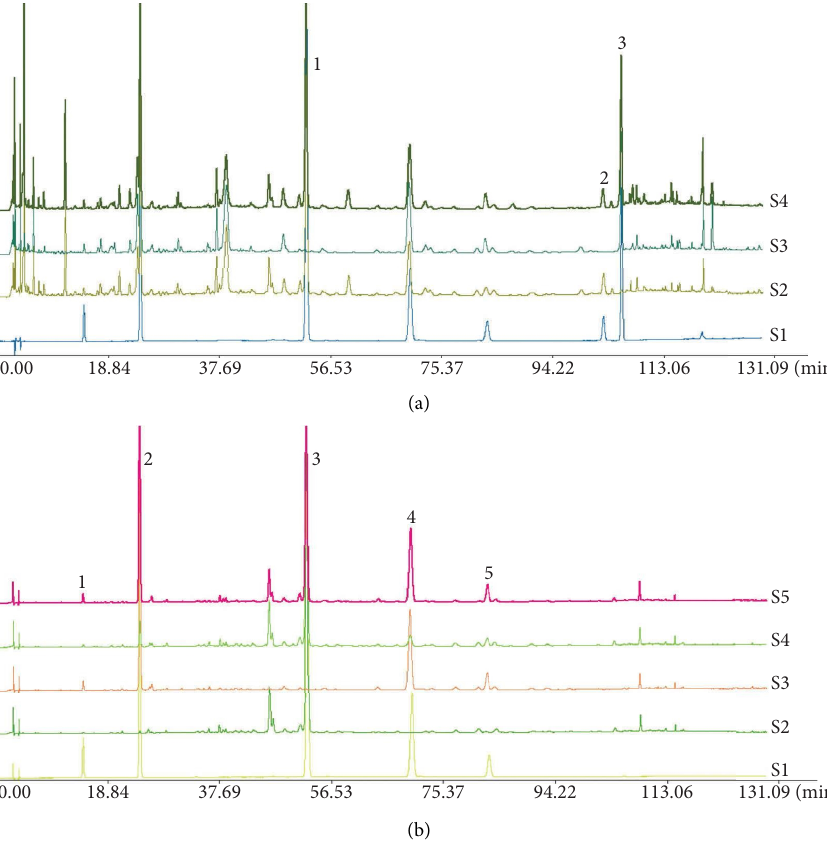
Figure 7: Chromatograms of yinqiao powder and negative control samples at 237nm (a) and 327nm (b). In panel a , 1. forsythoside A 2. phillyrin, 3. arctiin, S 1. mixed reference, S 2. negative control sample of Arctii Fructus , S 3. negative control sample of Forsythiae Fructus , S4. Yinqiao powder. In panel b , 1. neochlorogenic acid, 2. chlorogenic acid, 3. forsythoside A , 4. isochlorogenic acid A , 5. isochlorogenic acid C , S 1. mixed reference, S 2. negative control sample of Lonicerae Japonicae fos and Arctii Fructus , S3. negative control sample of Forsythiae Fructus , S4. negative control sample of Lonicerae japonicae fos , S5. Yinqiao